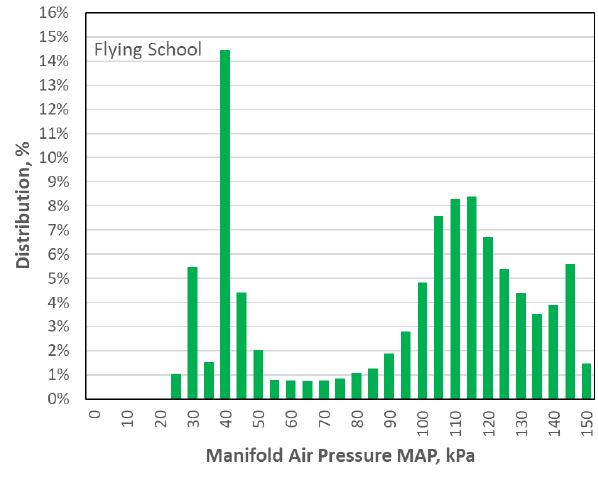
Fig. 8. Distribution of manifold air pressure during training flights This range (100–120 kPa), on the other hand, dominates for flights during the sport competition. It occupies more than 50% of the engine operating time, with the range around 115–120 kPa being the most represented (27.9%). As with the previous analyses, a much smaller share of idle and take-off power is evident here as